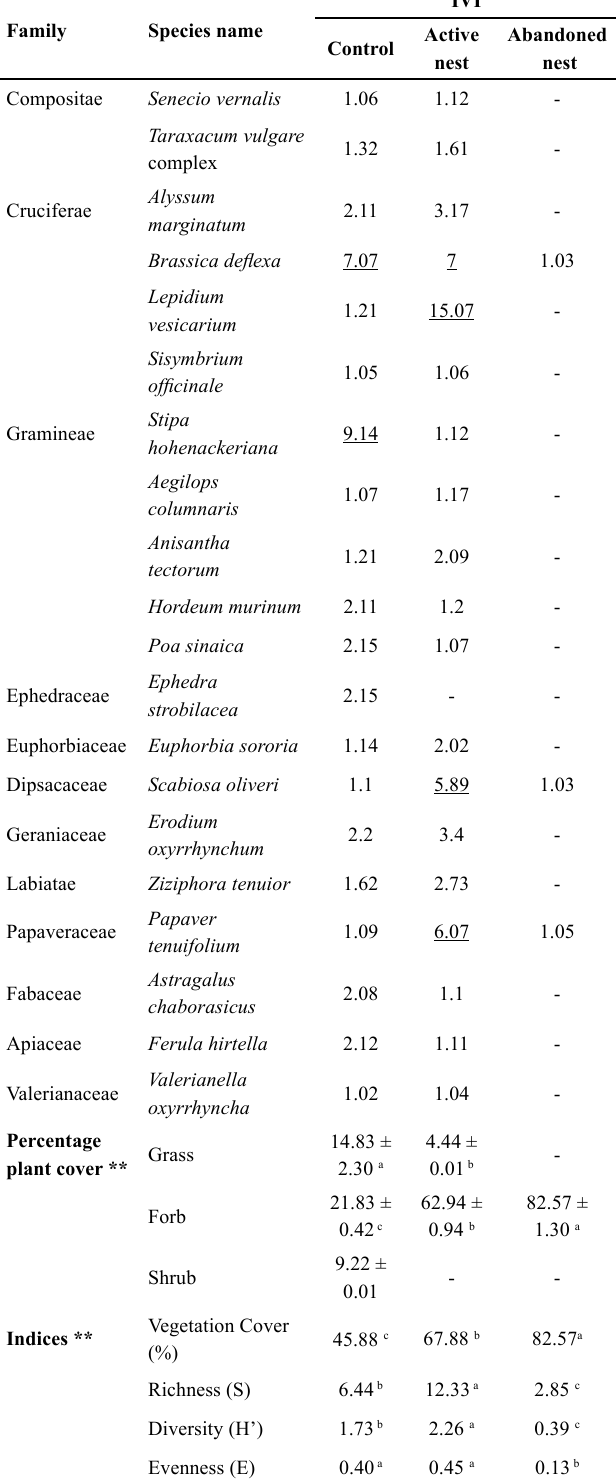
Table 3 . Above: Mean importance value index (IVI) for plants species and mean (± SE) percentage cover of different functional groups of plants. Below: Plant species richness (S), diversity (H'), and evenness (E) for active and abandoned Messor cf. intermedius nests and control sites (Mean ± SE).